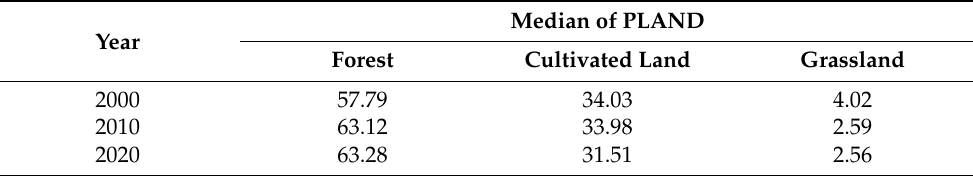
Table 3. Summary of the median values of PLAND at the class level.